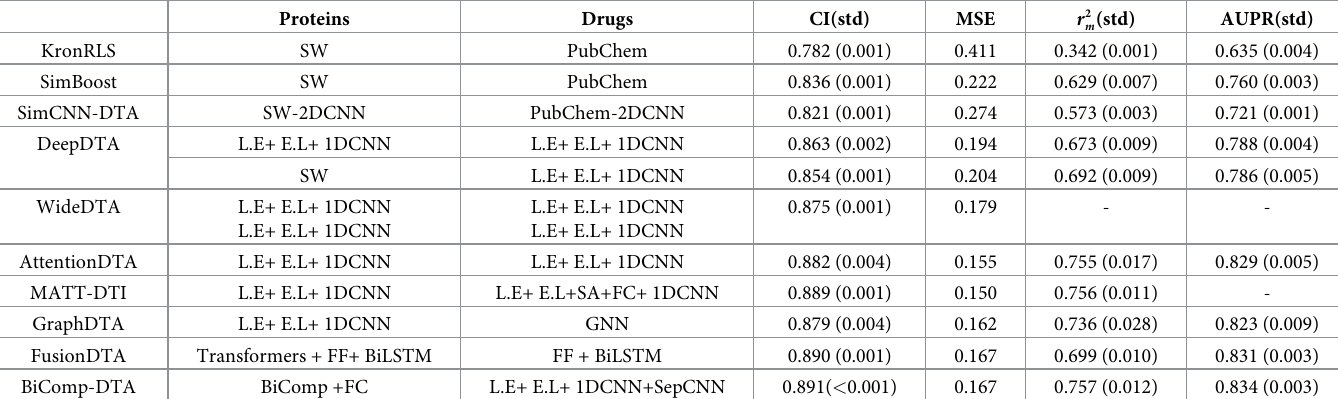
Table 2. The CI, MSE, r 2